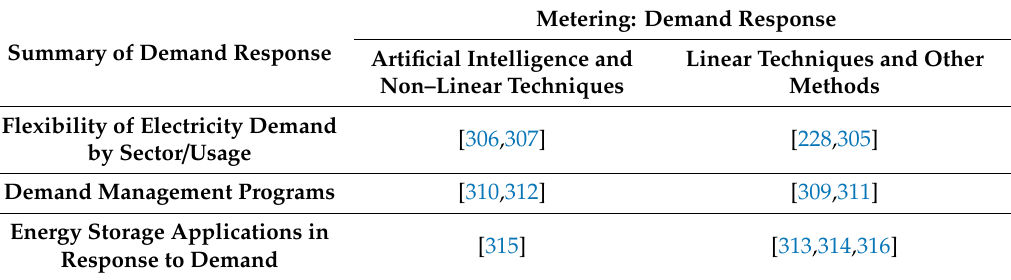
Table 16. Summary of Demand